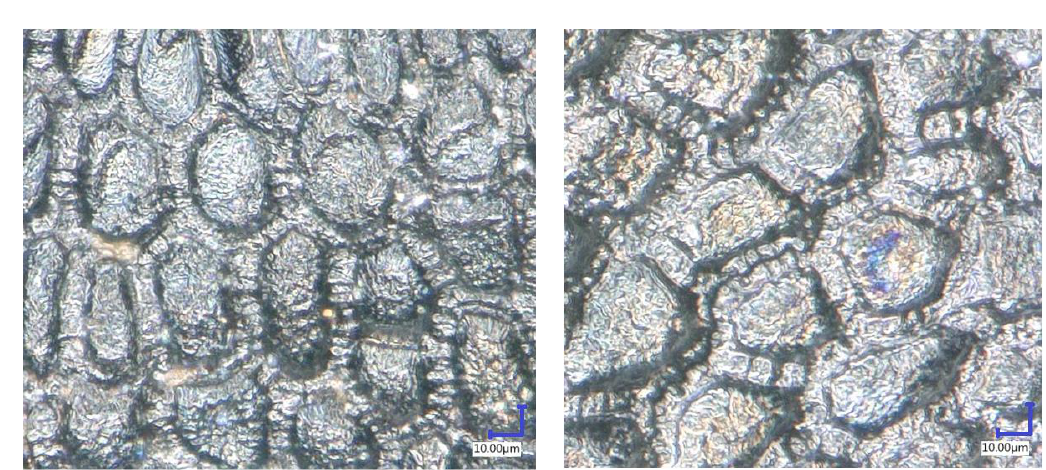
Figure 2. Comparison of the seeds’ surface before and after plasma treatment, 1000 magnification.